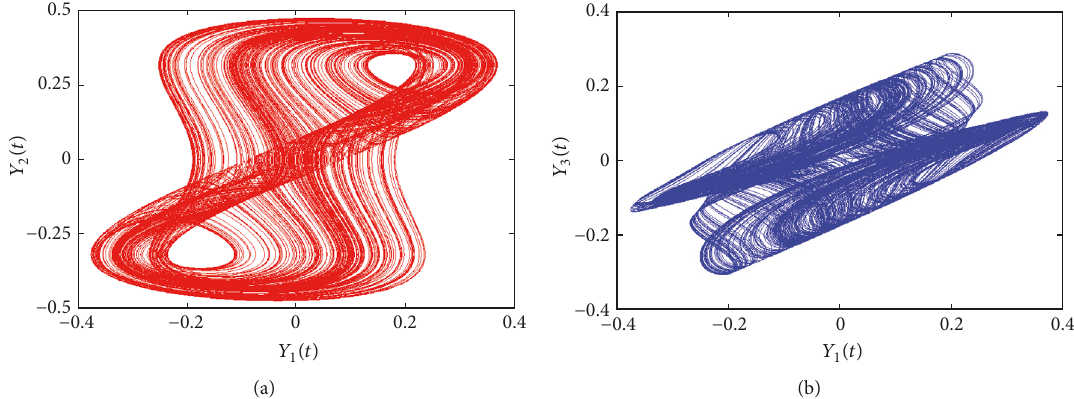
Figure 8: Typical chaotic phase portraits of system (14) with a = 0.7, b = 10, 𝛿 1 = 𝛿 3 = 0, 𝛿 2 = 10 −6 , and 𝛿 4 = − 0.5. (a) Phase portrait in the Y 1 ( t ) – Y 2 ( t ) plane. (b) Phase portrait in the Y 1 ( t ) – Y 3 ( t )